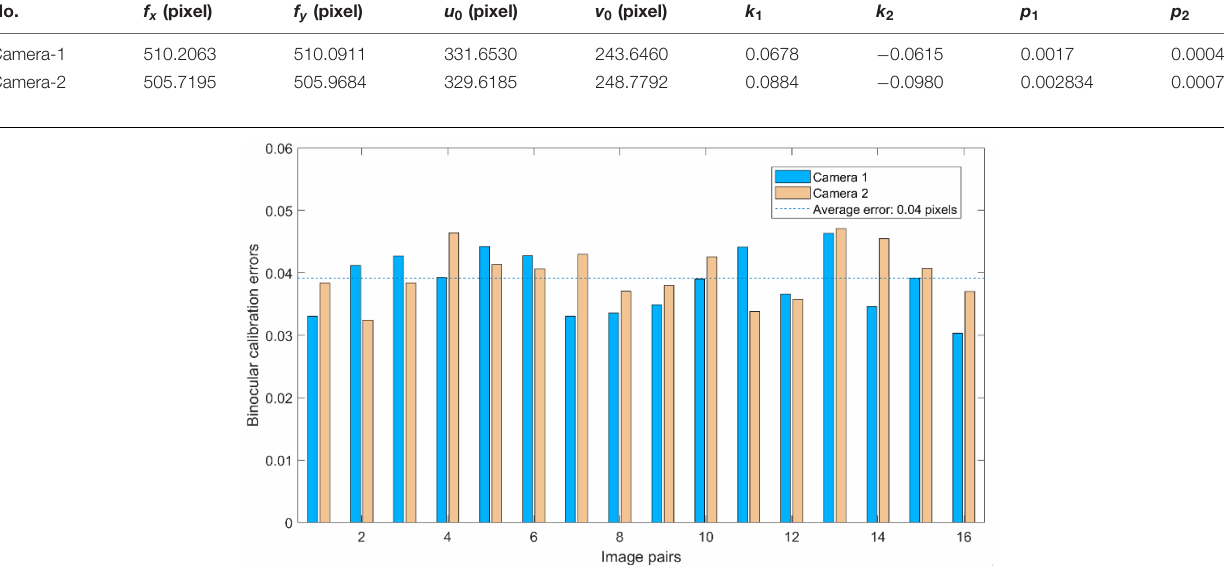
TABLE 1 | The intrinsic parameters and distortion coefficients of Camera-1 and Camera-2.